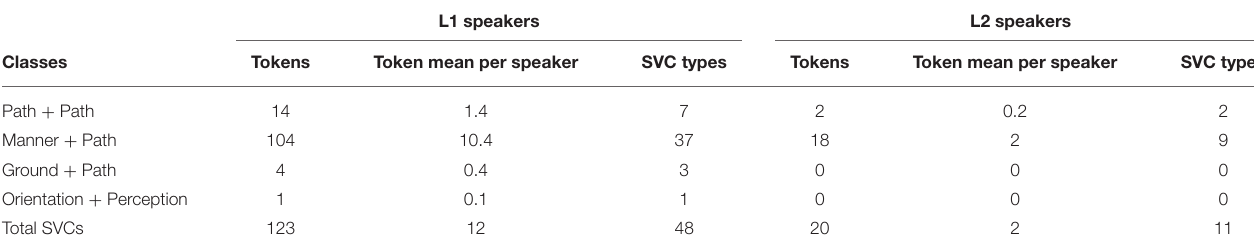
TABLE 6 | Different classes of SVCs in L1 and L2 narratives. L1 speakers L2